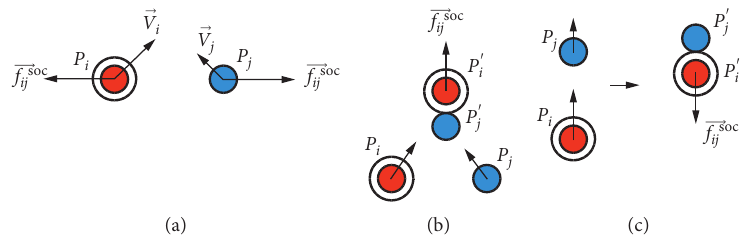
Figure 3: Comparison of avoiding force and original psychological repulsive force.